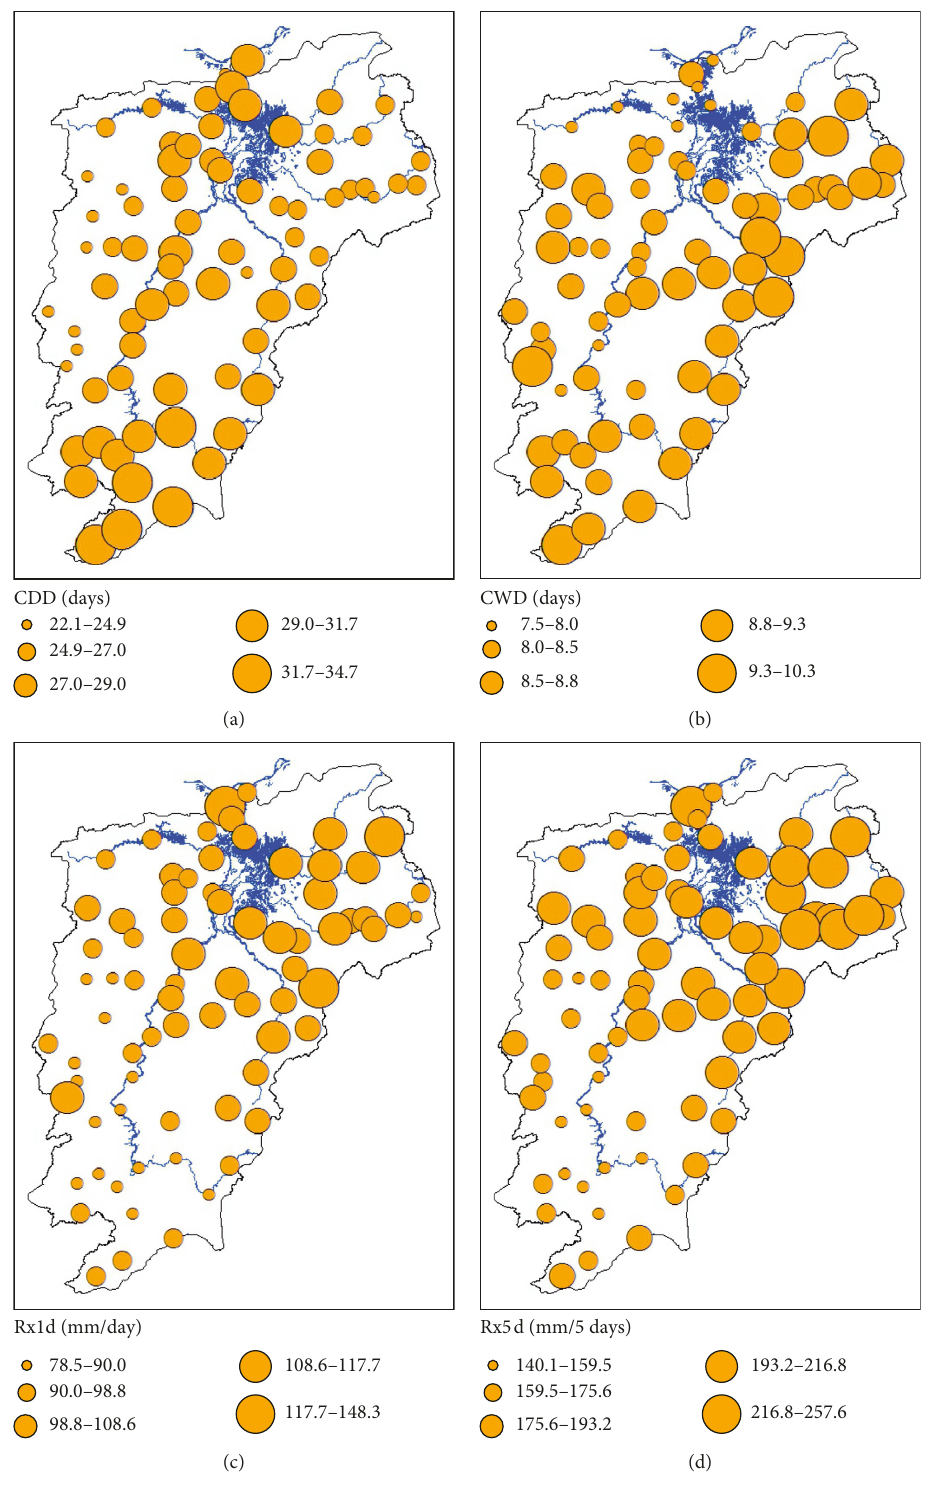
Figure 5: Spatial distributions of (a) CDD, (b) CWD, (c) Rx1d, and (d) Rx5d in Poyang Lake